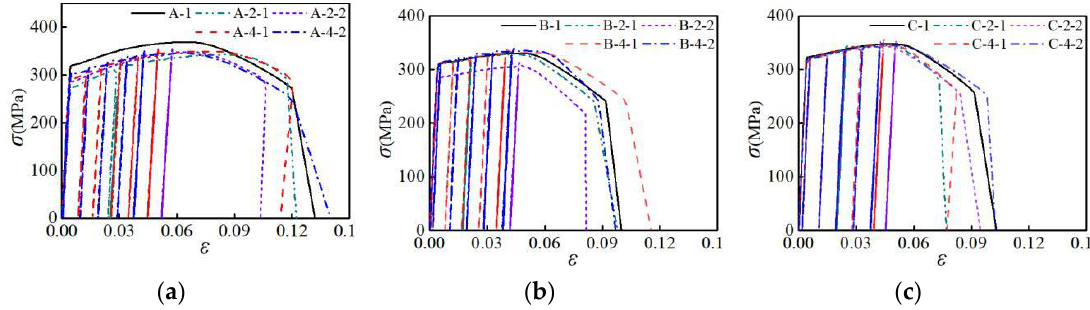
Figure 6. Influence of different loading pattern on stress-strain curve: ( a ) group A of specimens; ( b ) group B of specimens; ( c ) group C of specimens.